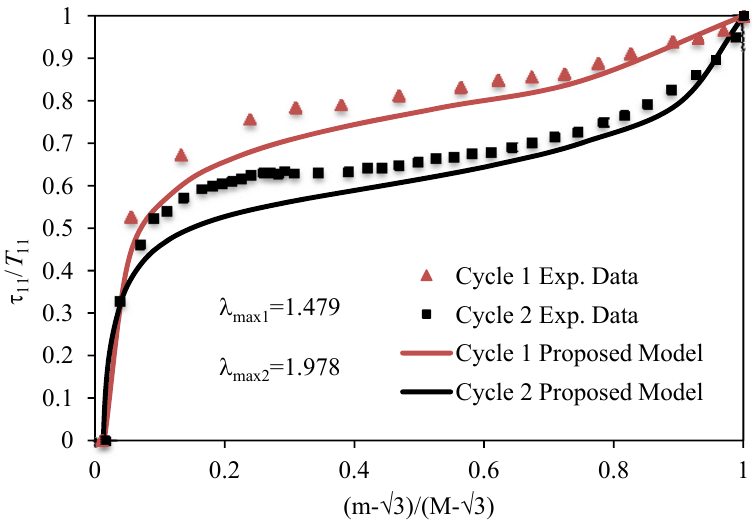
Figure 3. Comparison of theoretical predictions computed from Equations (16) and (25) with experimental data collected from a 12.2% w fraction of MWCNT-reinforced elastomer by plotting the normalized stress ratio intensity ratio ( m – √ 3)/( M – √